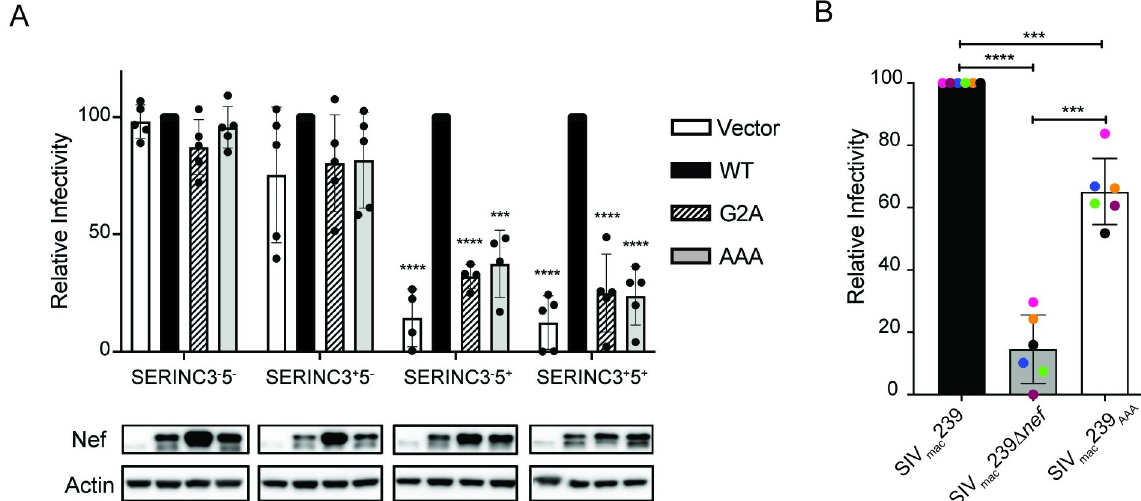
Fig 3. Nef AAA substitutions impair SERINC5 antagonism and SIV mac 239 AAA infectivity. The infectivity of Nef- trans -complemented SIV mac 239 Δ nef produced in JTAg cells with knock-out mutations in SERINC3 (SERINC3 - 5 + ), SERINC5 (SERINC3 + 5 - ), both (SERINC3 - 5 - ) or neither (SERINC3 + 5 + ) (A) and viruses harvested from infected rhesus macaque CD4 + lymphocytes (B) were compared. (A) Nef- trans - complemented virus was collected 48-hours after co-transfection of JTAg cells with SIV mac 239 Δ nef and expression constructs for wild-type Nef (WT), Nef G2A (G2A), Nef AAA (AAA) or empty vector (Vector). Nef expression was also verified by western blot analysis of JTAg cell lysates. (B) SIV mac 239, SIV mac 239 Δ nef and SIV mac 239 AAA were collected after six days of replication in activated CD4 + lymphocytes from six different rhesus macaques, virus concentrations were measured by SIV p27 antigen-capture ELISA, and C8166-SEAP cells were infected in triplicate with equivalent doses of each virus (0.5 ng p27 per 1x10 4 cells). Secreted-alkaline phosphatase (SEAP) activity was measured in the cell culture supernatant 72-hours later. Relative infectivity is shown as a percentage of wild-type Nef or SIV mac 239 infection. Error bars indicate standard deviation of the mean for at least four independent experiments (A) or six different animals (B). Significant differences are indicated by asterisks ( ��� p < 0.001 & ���� p < 0.0001, two-tailed unpaired t -test with Welch’s correction in case of unequal variance).